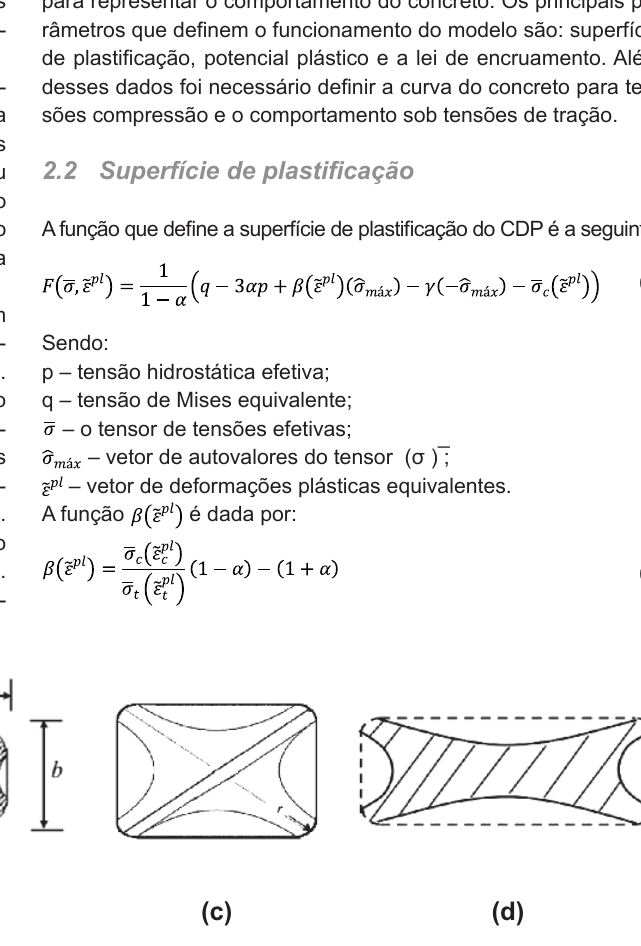
Figura 2 Tipos de configuração da região efetivamente confinada: (a) sugerido pela Fib [24]; (b) sugerido por Tan et al. [15]; (c) indicado no ACI 440.2R-08 [1] e (d) sugerido por Harajli